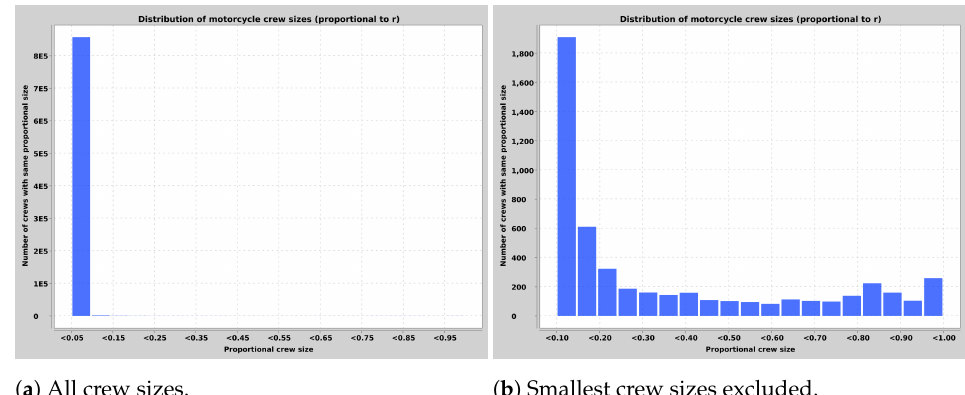
Figure 15. Histogram of motorcycle crew sizes in relation to the number of reflex vertices. Data for 2700 polygons with at least 100 reflex vertices from Salzburg Database of Geometric Inputs [10].